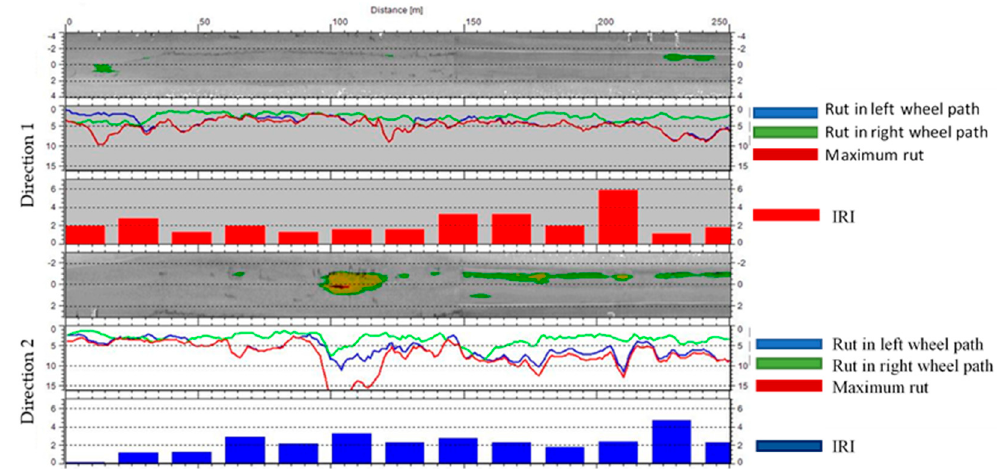
Figure 5. Graphical evaluation of the rutting and IRI parameters detection (date 9 December 2020).